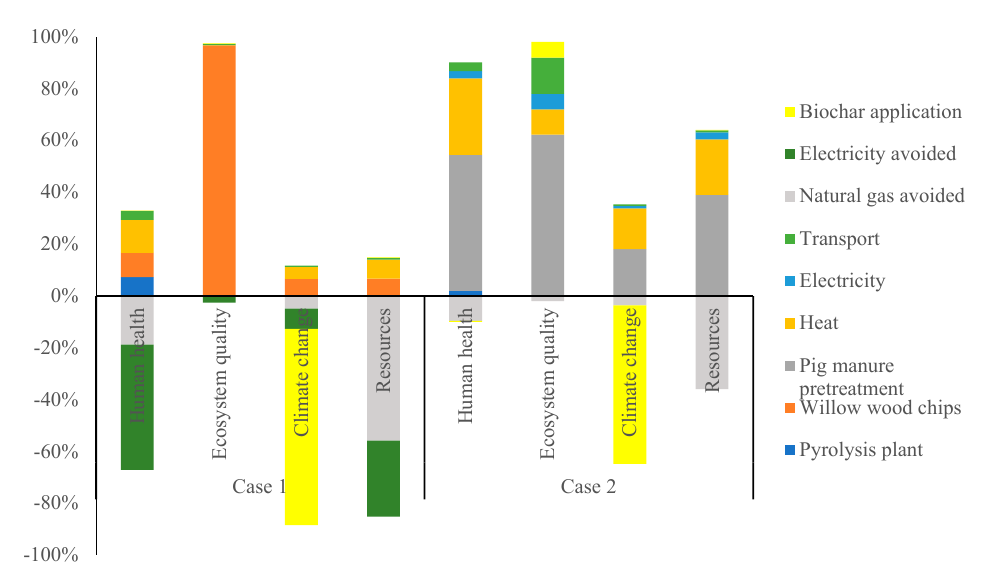
Figure 3. Process contribution to the damage categories.